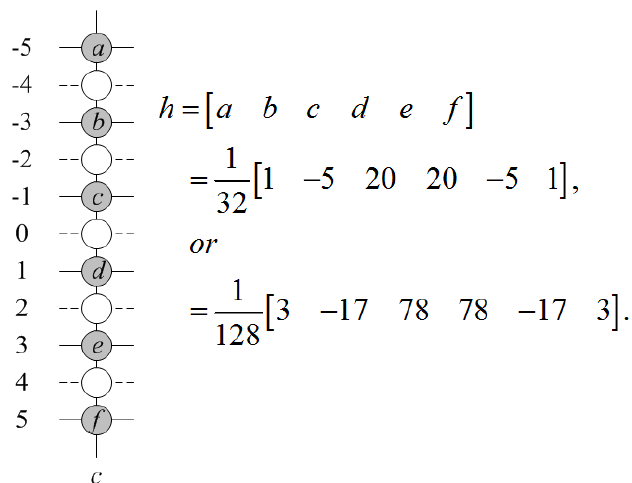
Figure 1. The pixel positions with filter